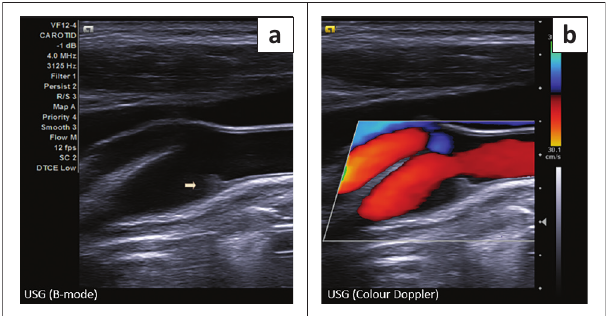
FIGURE 4 : (a) Ultrasound of right carotid bulb in longitudinal section revealed a shelf-like intimal projection from the posterior wall (arrow); no calcification or thrombus seen. (b) Patent flow on colour